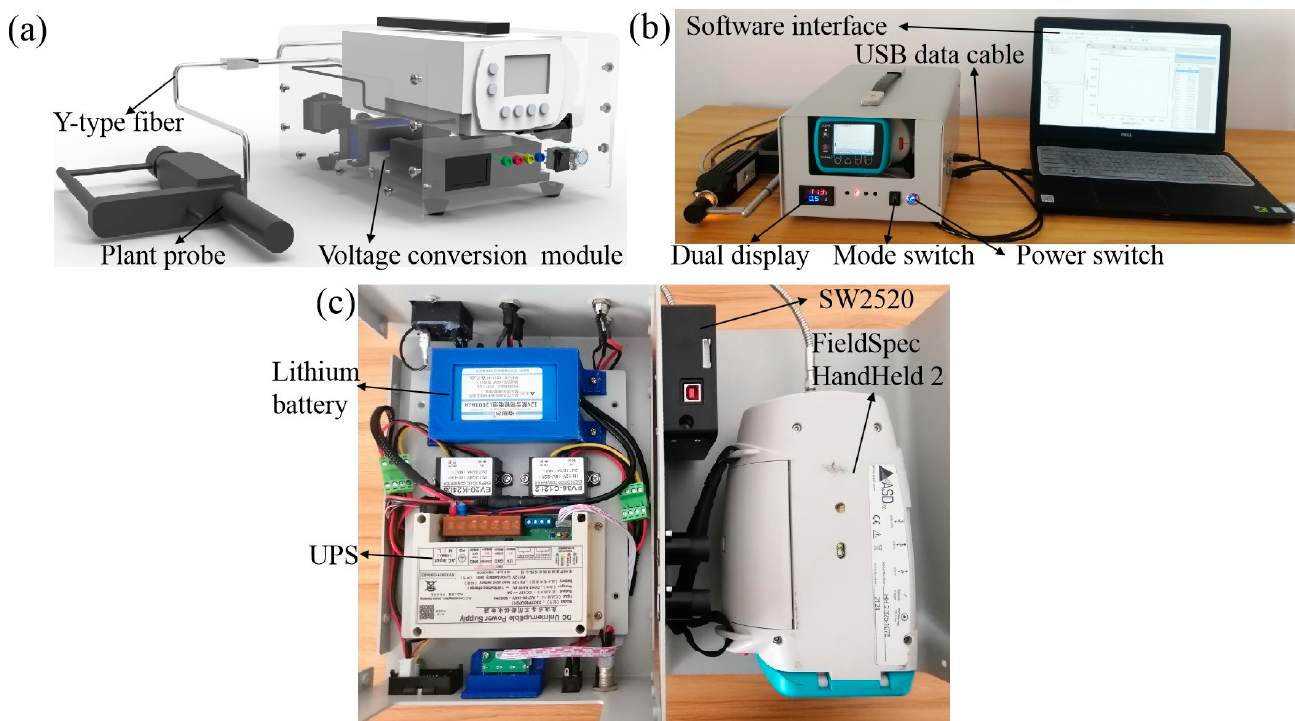
Figure 2. Portable non-destructive detecting device for tea polyphenols in fresh tea leaves: structure diagram ( a ), physical diagram ( b ), and internal diagram ( c ).